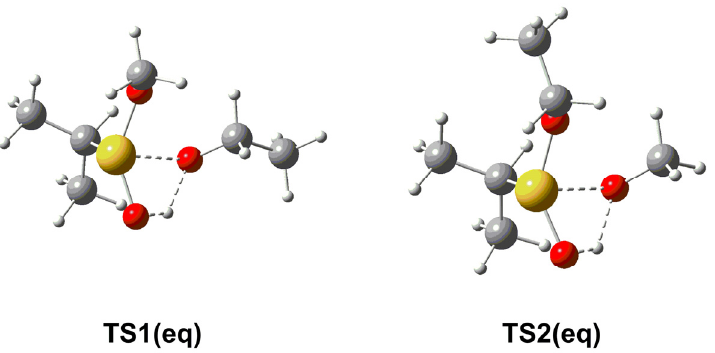
Figure 3. Transition states for the equatorial departure of the alkoxy group, assisted by the apical OH group; color meaning: sulfur — yellow, oxygen — red, carbon — grey, hydrogen — white.